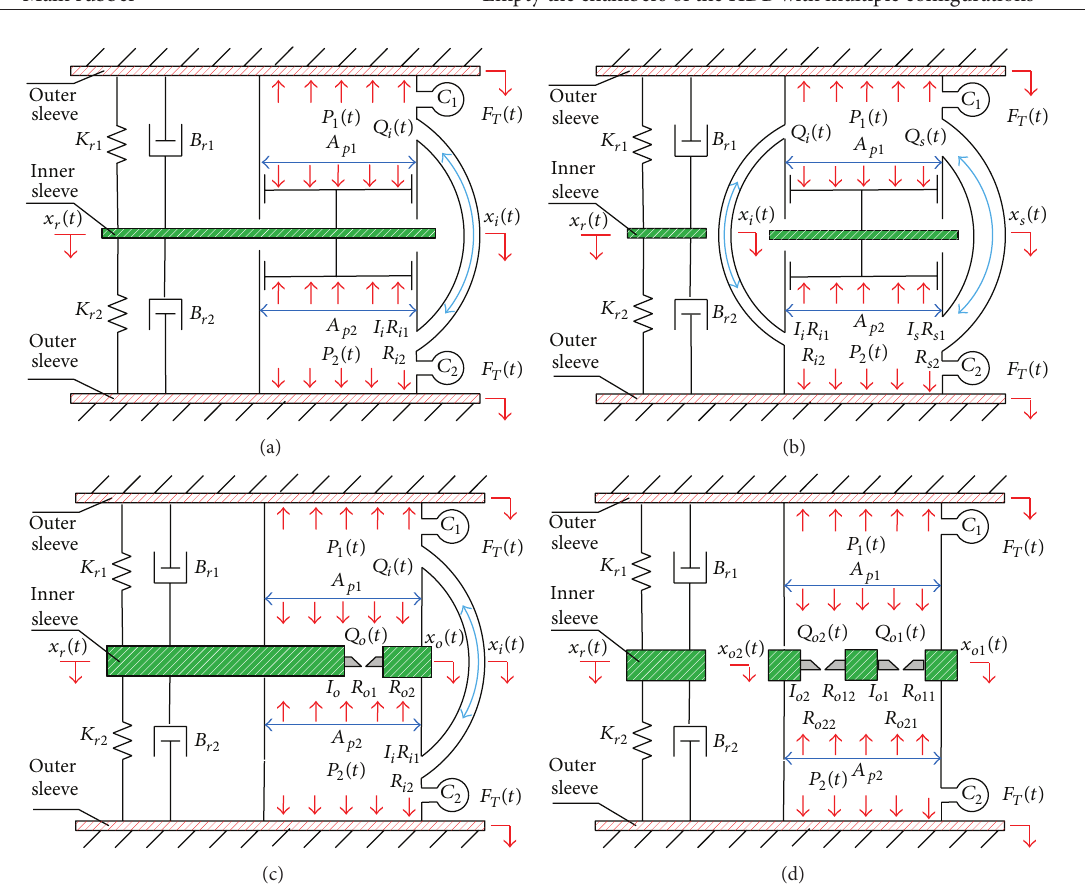
Figure 3: Fluid system model for HDBs with multiple configurations. (a) One inertia track; (b) two inertia tracks; (c) one inertia and an orifice; (d) two